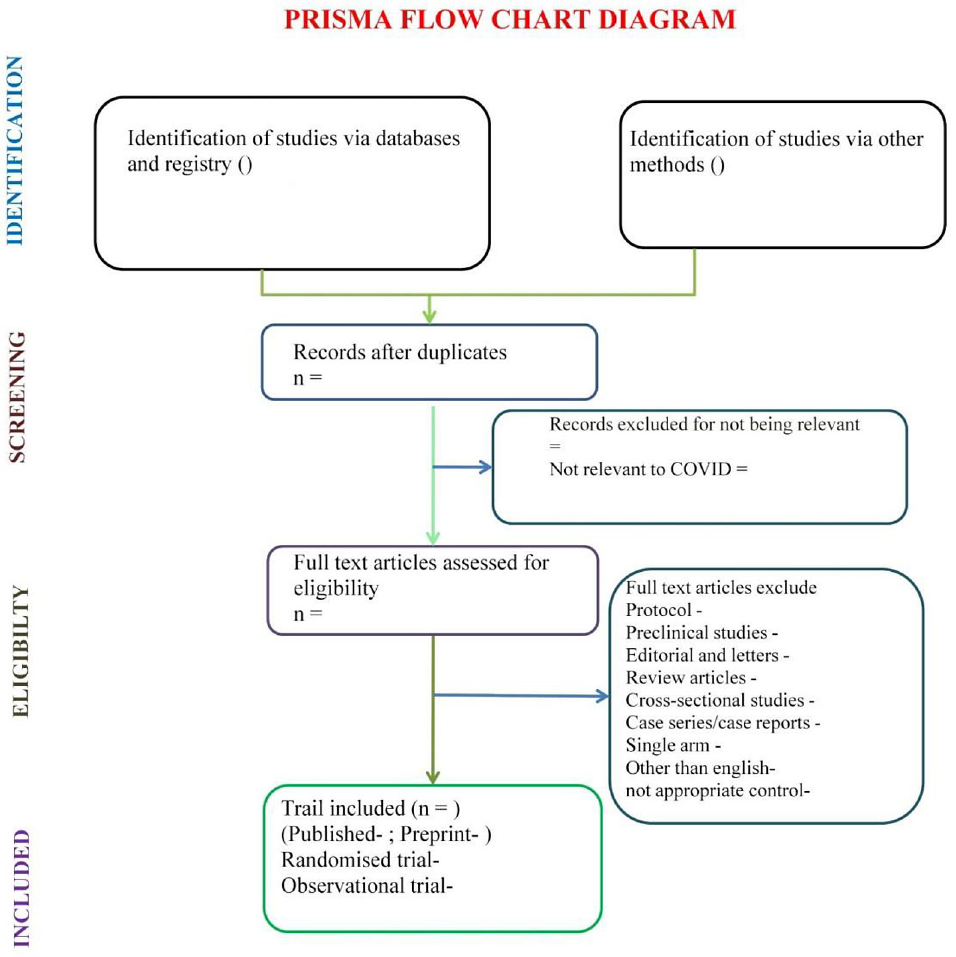
Figure 1. PRISMA flow chart for study selection process. Flow chart covers the plan of study selection process of living systematic